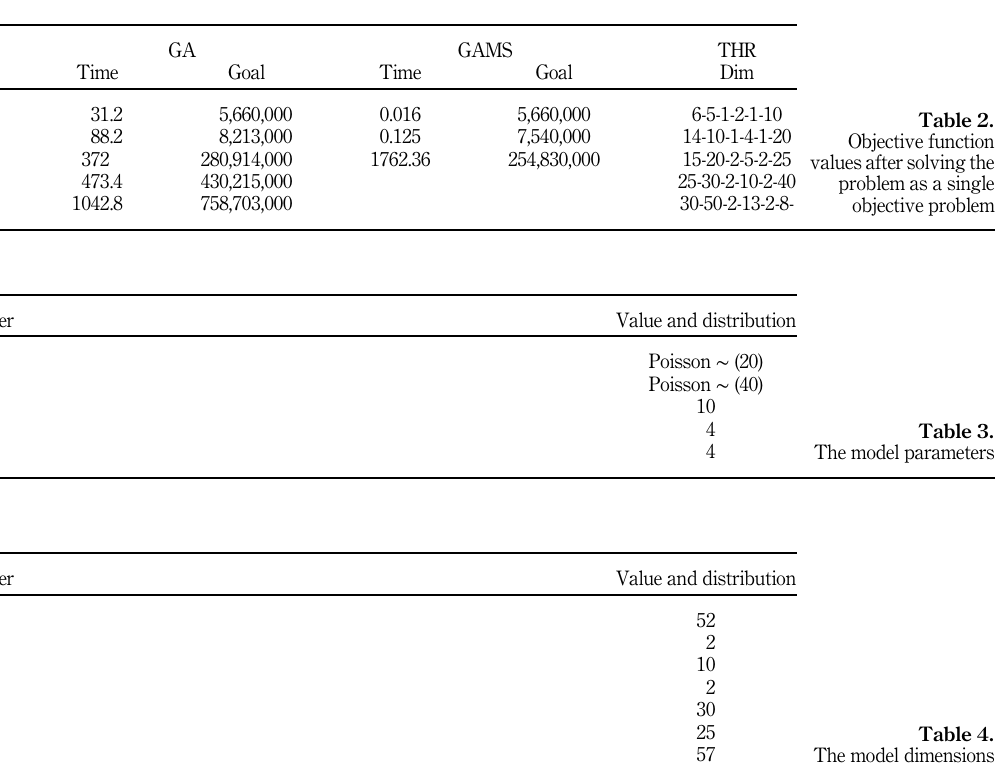
Table 4. The model